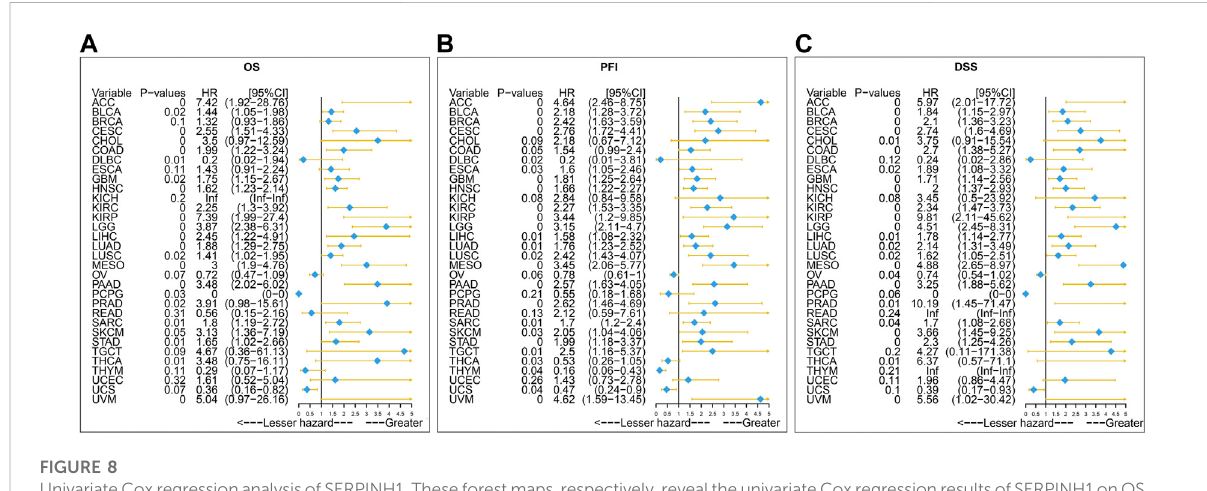
FIGURE 8 UnivariateCoxregressionanalysisofSERPINH1.Theseforestmaps,respectively,revealtheunivariateCoxregressionresultsofSERPINH1onOS (A) ,PFI (B), andDSS (C) inTCGApan-cancer.Itemswithahazardratiogreaterthan1showedthattheSERPINH1 expressionwasacontributing factor to